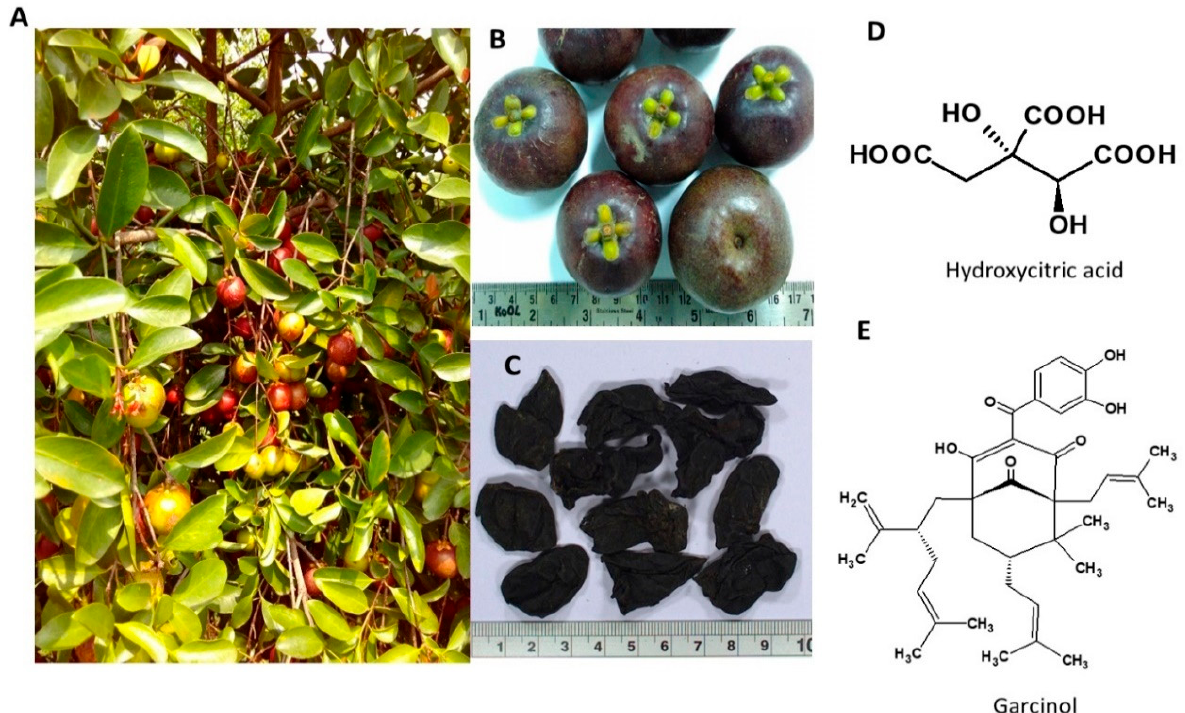
Figure 4. Garcinia indica . ( A ) Habitat of the Plant; ( B ) Ripe fruits; ( C ) Dried fruit rinds; ( D ) Hydroxy citric acid; ( E ) Garcinol. Garcinol is a yellow crystalline poly ‐ isoprenylated benzophenone derivative ex ‐ tracted from fruit rind of Garcinia indica [92]. The extract of G. Indica standardized for 20% w/w Garcinol inhibited the differentiation of 3T3 ‐ L1 preadipocytes in vitro by downreg ‐ ulating the adipogenic genes and by increasing the transcripts associated with energy me ‐ tabolism and adipocyte browning [93]. In the animal model, Garcinol induced a dose ‐ dependent reduction of total body weight and visceral adipose tissue in high ‐ fat diet ‐ (HFD) ‐ induced obese mice. Garcinol mediated the anti ‐ obesity activity by reducing endo ‐ plasmic stress in preadipocytes and adipose tissues. The results suggested a novel molec ‐ ular mechanism of Garcinol’s action, acting on the AMPK ‐ ER stress axis [93]. Lee et al. reported a similar result, wherein Garcinol administration to HFD ‐ fed mice showed a re ‐ duction in glutamate pyruvate transaminase, total cholesterol, and triacylglycerol. In this study, Garcinol reversed gut dysbiosis by decreasing the Firmicutes ‐ to ‐ Bacteroidetes ratio and controlled inflammation by increasing intestinal commensal bacteria, Akkermansia muciniphila, which has been strongly and negatively correlated with age and HFD feeding